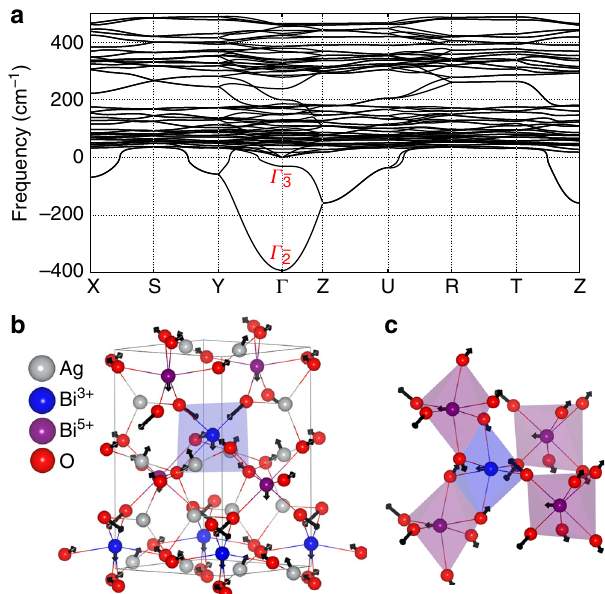
Fig. 2 Phonon properties of Pnna -structured Ag 2 BiO 3 . a Phonon dispersions of the hypothetical paraelectric phase Pnna . Negative frequencies correspond to imaginary modes. b , c The atomic displacements (force constant eigenvectors, black arrows) of the Γ 2 (cid:3) mode in real space for BiO 6 octahedra and Ag cations, respectively. Note that the amplitude of Ag and Bi cation are enlarged for clarity. The color coding for atoms matches that in Fig.